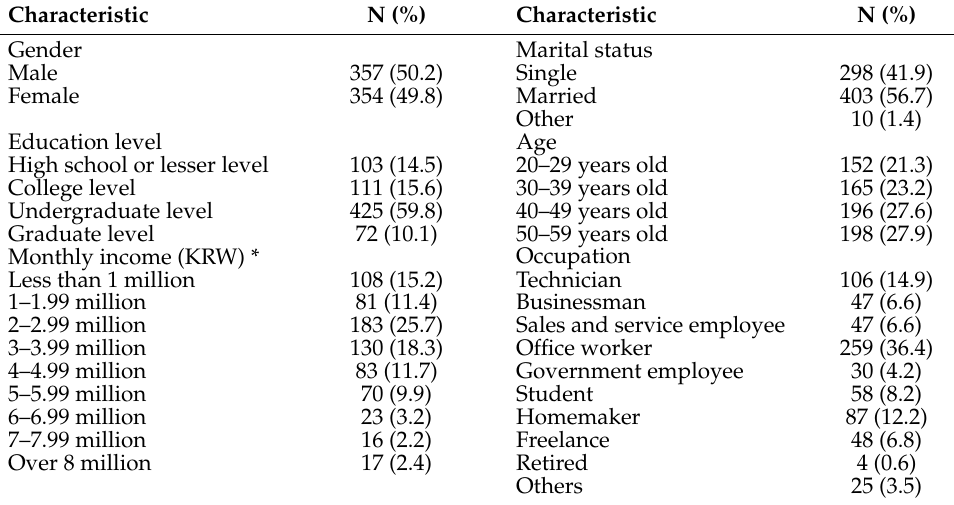
Table 1. Demographic characteristics of the respondents (N =